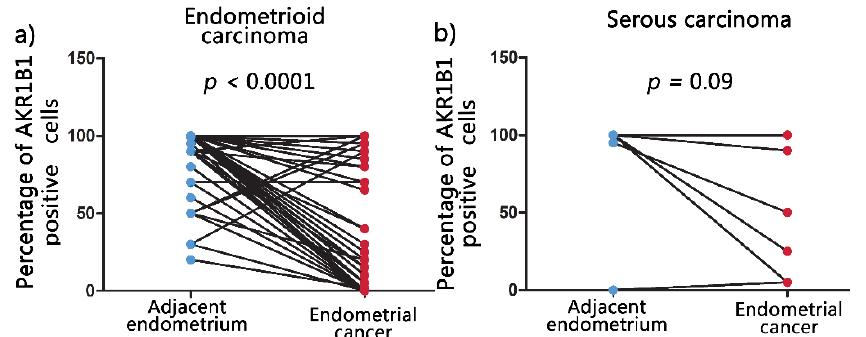
Figure 4. AKR1B1 immunohistochemical expression in EC and the adjacent non-neoplastic endo- metrial tissue. Before and after graphs show the expression of AKR1B1 in endometrial cancer tis- sue and its paired adjacent non-neoplastic endometrial tissue. ( a ) Adjacent non-neoplastic endo- metrial tissue ( n = 61, mean = 90.1, median = 100, IQR = 10) compared to endometrioid EC ( n = 61, mean = 55.8, median = 70.0, IQR = 90.0). ( b ) Adjacent non-neoplastic endometrial tissue ( n = 9, mean = 88.3, median = 100, IQR = 2.5) compared to serous EC ( n = 9, mean = 63.9, median = 90.0, IQR = 85.0). AKR1B1: aldo-keto reductase family 1 member B1; IQR: interquartile range; N : num- ber of patients.